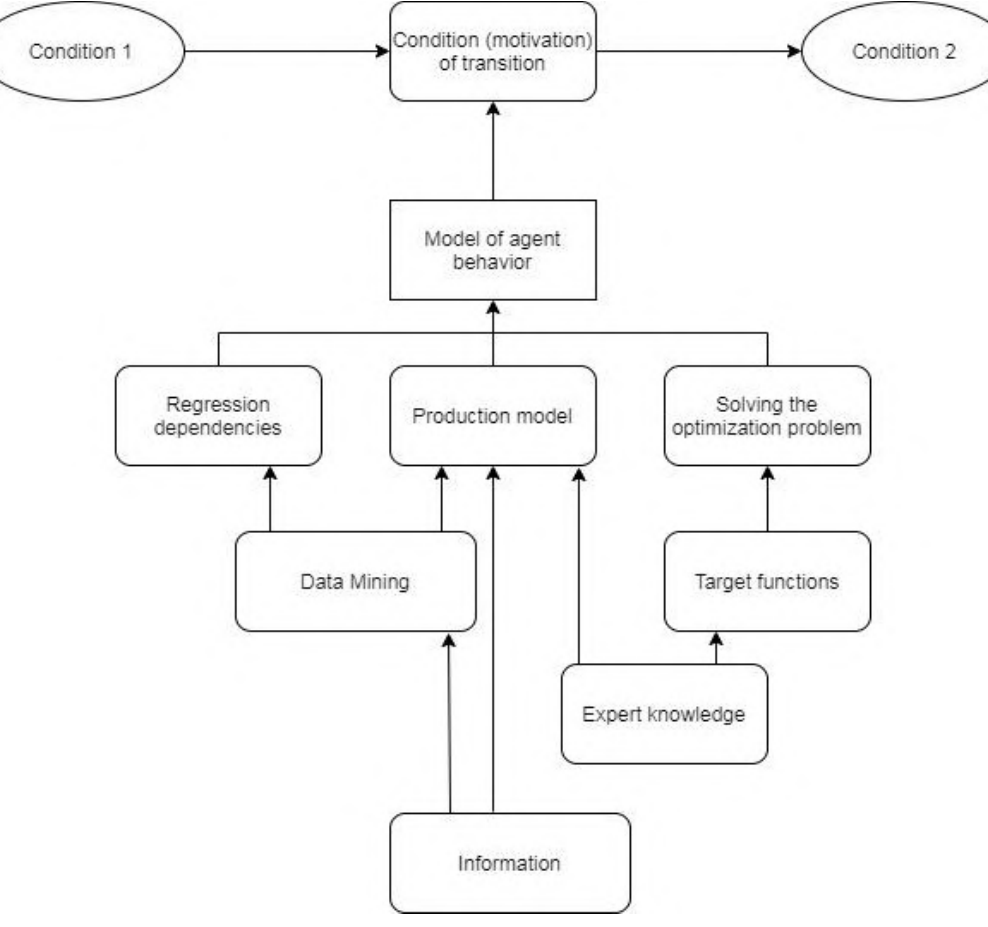
Figure 3: Model of agent behavior